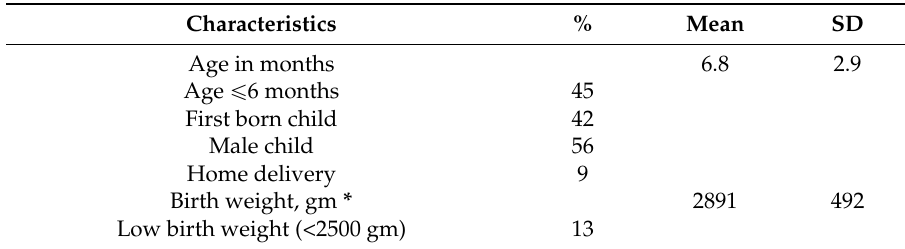
Table 2. Baseline characteristics among 467 healthy infants participating in micronutrient survey